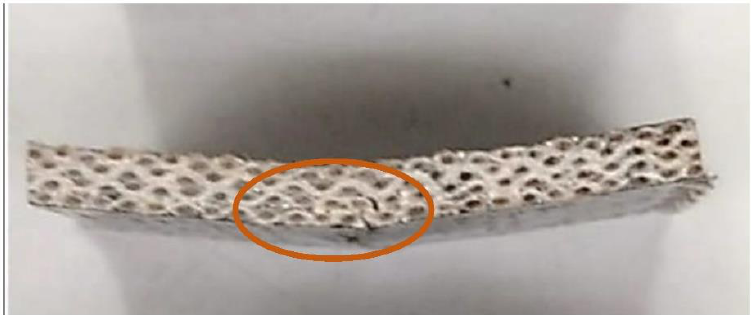
Figure 15. UD fabric sample with an interlaminar shear type of crack (own source).